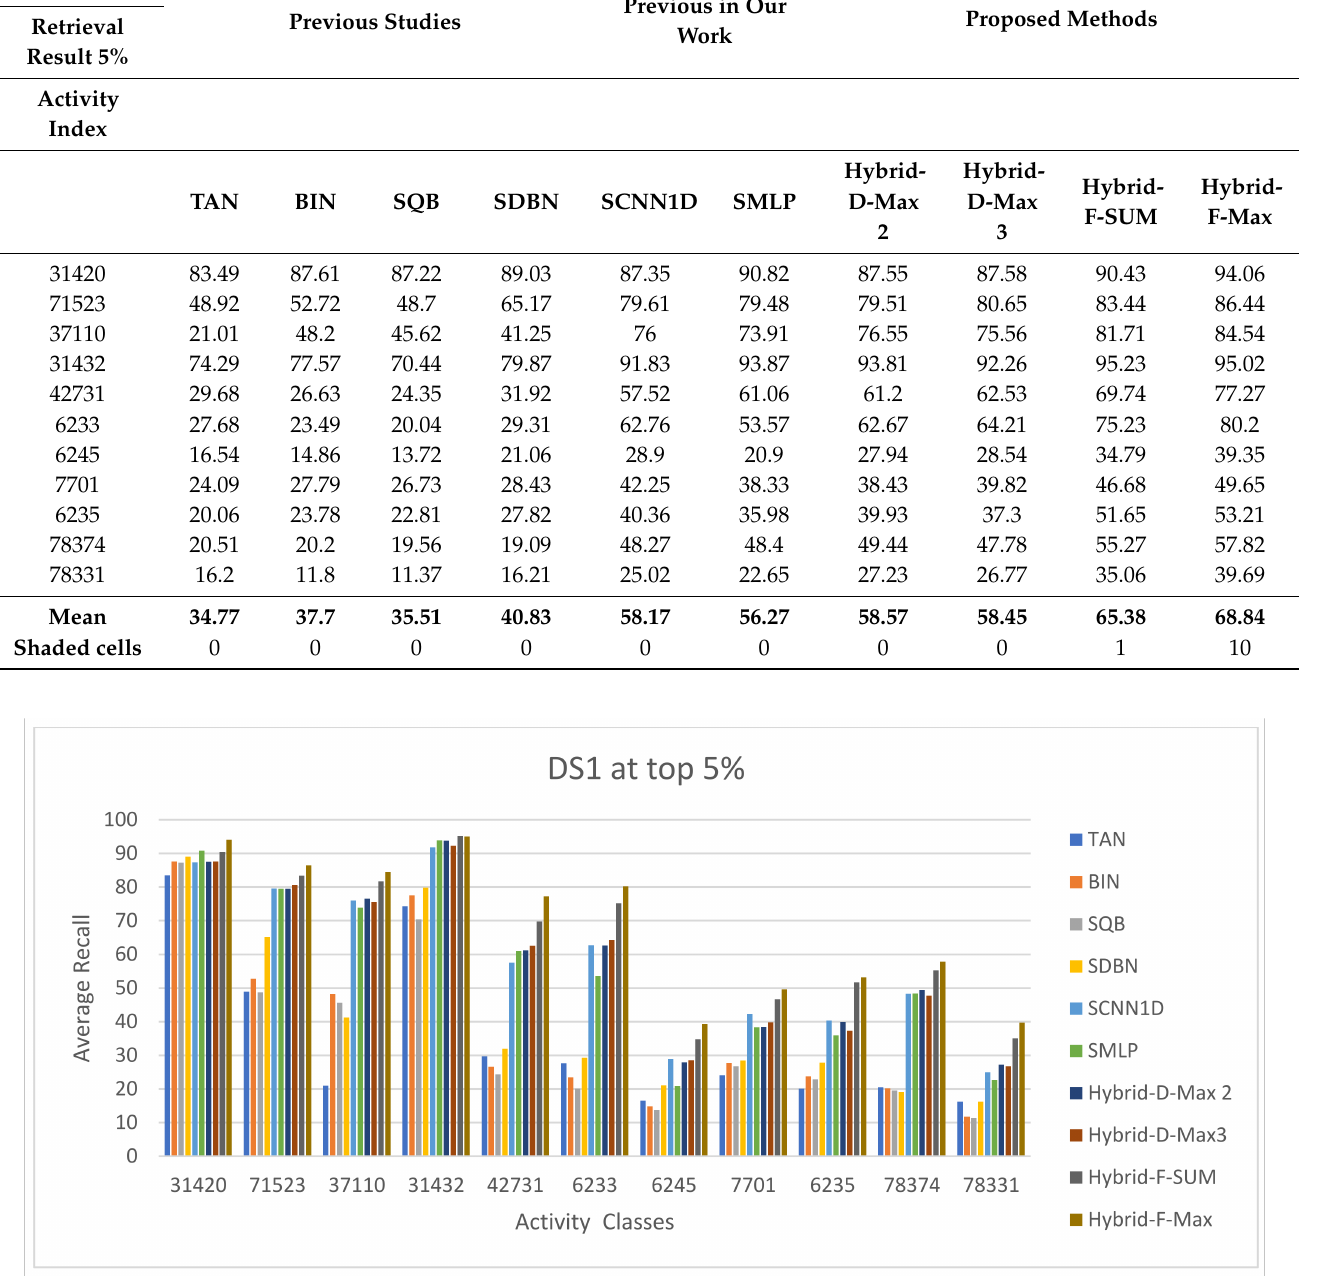
Figure 9. The comparison among methods for the average recall percentage at the top 5% in MDDR- DS1 (homogeneous and